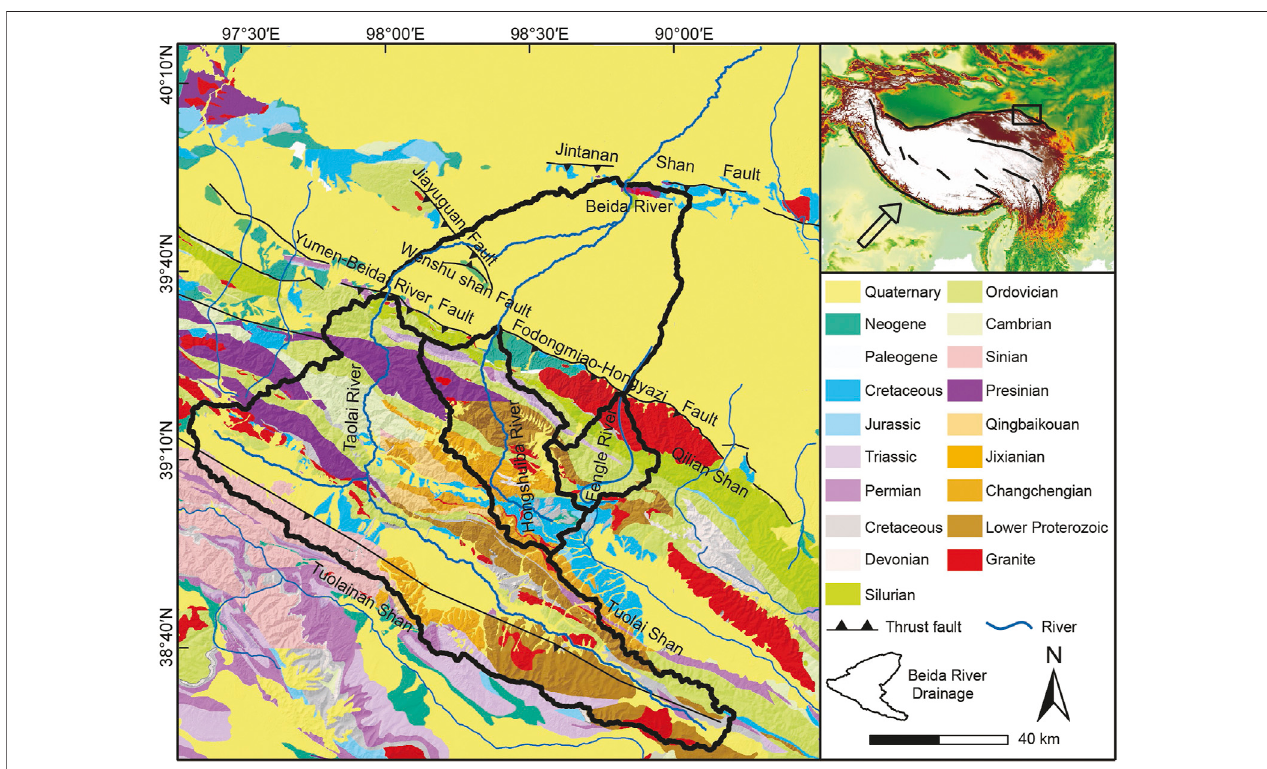
FIGURE 1 | Geological map of the Beida River catchment. Its scale is 1:200,000, revised from the Gansu Geological Bureau (1967). Major faults, rivers, sub- catchments,andmountainshavebeenpresentedwithinthiscatchment.ThesefaultsrevisedfromGansuGeologicalBureau(1967).Theinsetmapindicatesthelocation of this catchment in the northeastern margin of the Tibetan